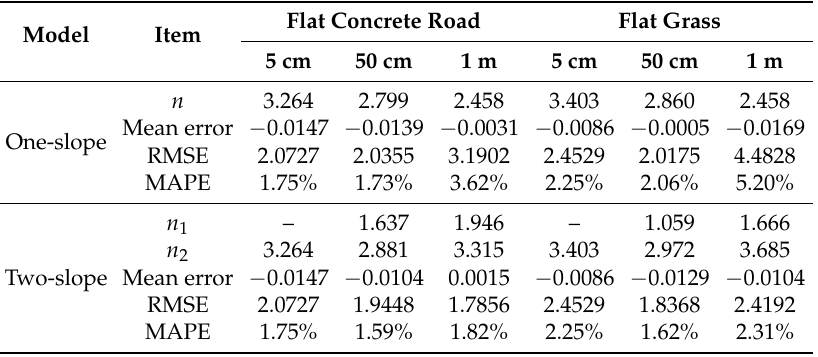
Table 1. Model parameters and precision.